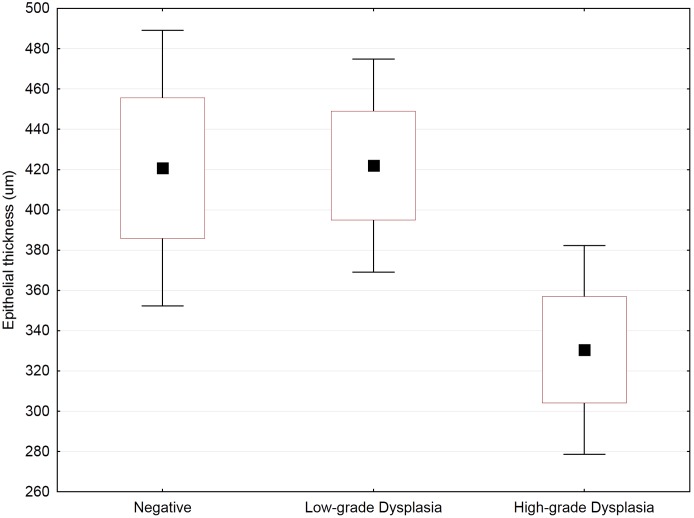
Epithelial thickness of normal epithelium in patients with no abnormalities, patients with LGSIL (i.e. CIN1), and patients with HGSIL (i.e. CIN2/3).No variability due to age was observed. The mid-point represents the median value; boxes represent the 25th percentiles; and whiskers represent the 95th percentiles. Factorial ANOVA testing was followed by a post hoc Fisher LSD test for group-by-group comparisons, yielding: p = 0.97 for a normal vs. LGSIL comparison; p = 0.048 for a normal vs. HGSIL comparison; and p = 0.020 for a LGSIL vs. HGSIL comparison.